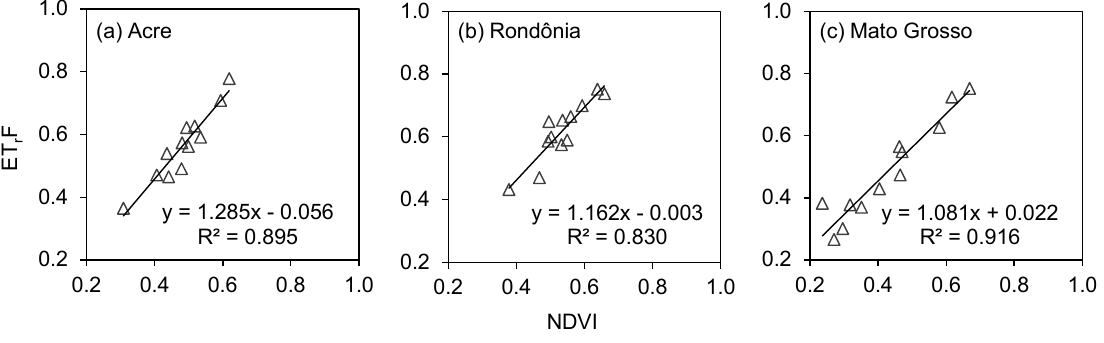
Figure 4. ET r F vs. NDVI relationships from pasture samples at all study sites. Each triangle point represents the averaged values of ET r F 1 (from METRIC 1 ) and NDVI for each one of the selected satellite image dates for the top 20% of NDVI samples.